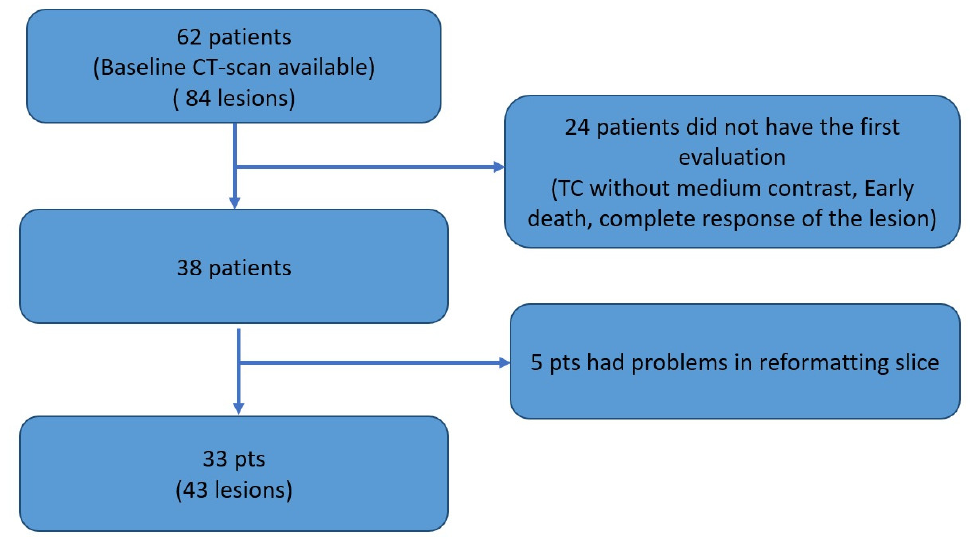
Figure 1. Consort diagram for selection of patients and lesions.